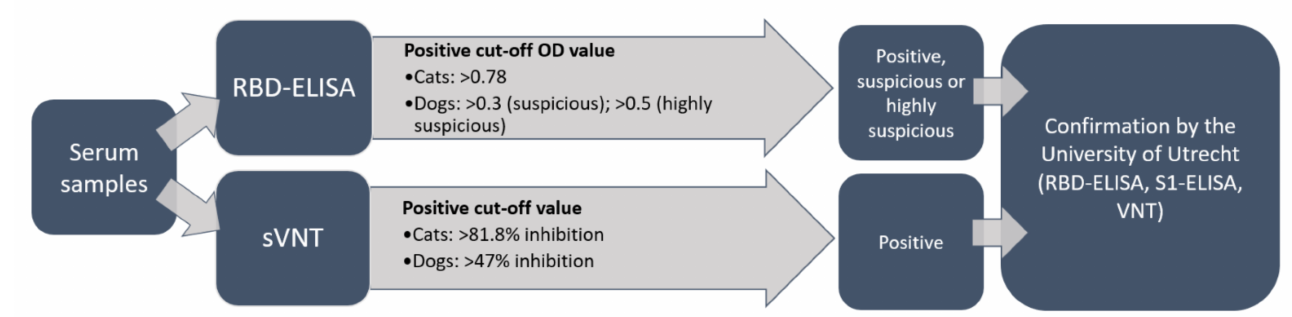
Figure 2. Workflow of serological analysis. The collected sera ( n = 118) were analyzed in parallel by an enzyme linked immunosorbent assay (ELISA) for the presence of antiSARS-CoV-2 receptor-binding domain (RBD) antibodies and by a surrogate virus neutralization test (sVNT) for neutralizing activity. Positive, suspicious, and highly suspicious samples were confirmed by the University of Utrecht. (OD = optical density; S1 = spike protein subunit 1; VNT = virus neutralization